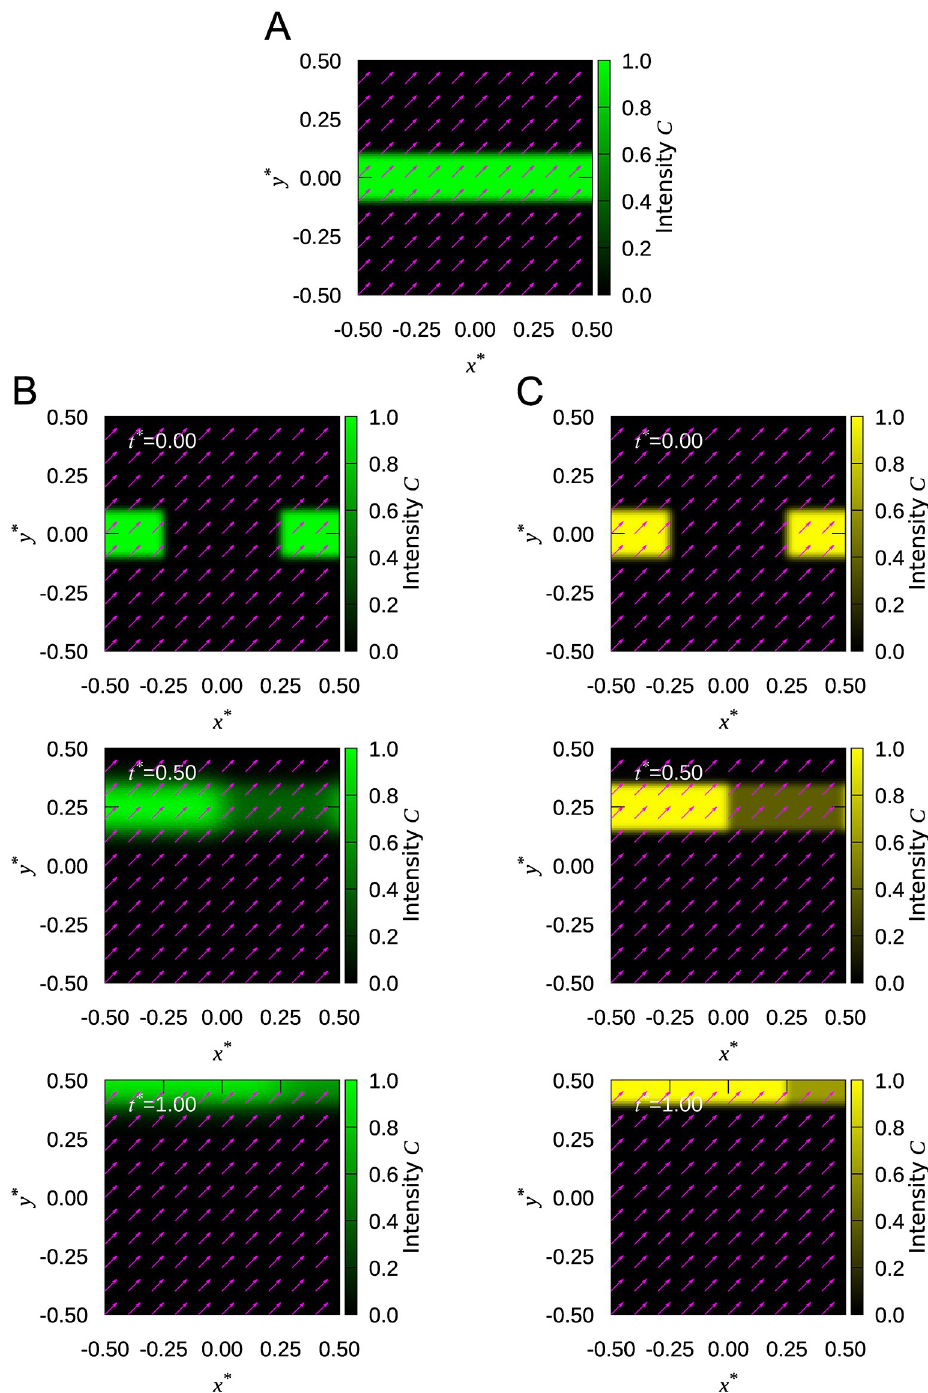
Fig 3. Numerical simulation validates the advection-reaction model. (A) The pre-bleach distribution expressed by Eq (8). The arrows represent the velocity vectors. (B) FRAP responses simulated by the first-order upwind scheme (see S1 Video). (c) FRAP responses fitted by the least-square method (see S2 Video).